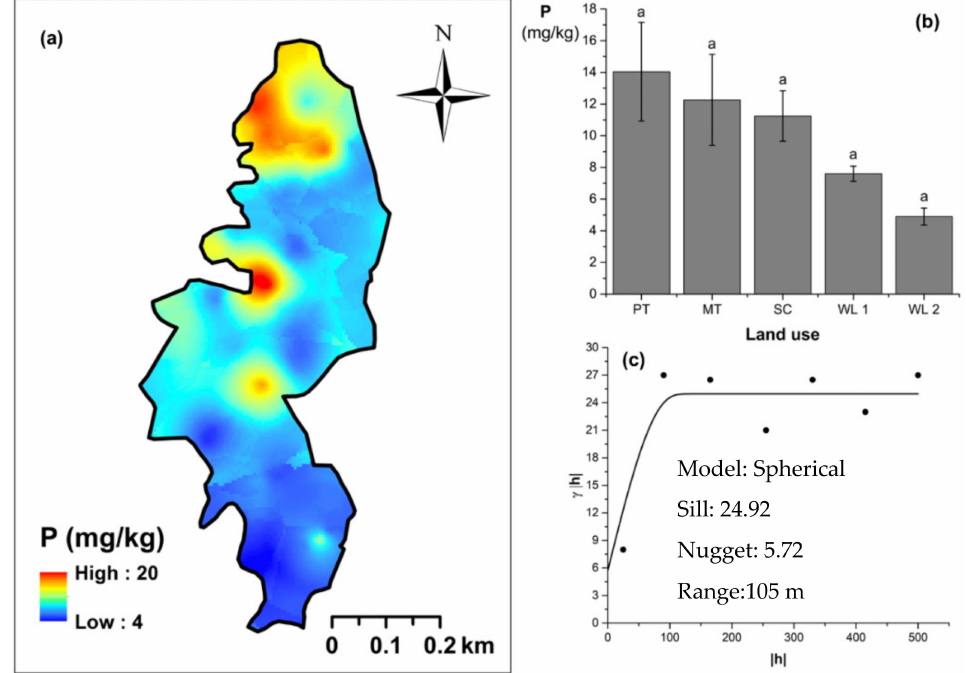
Figure 5. Spatial variability of available phosphorous: ( a ) map, ( b ) bar graph among different land uses (see Figure 1, label A for notations) in the Endane Biodiversity Corridor, and ( c ) variogram between lag distance and semivariance. Semivariance function: γ ( h ) = 5.72 + 0.356 h − 1.076 h 3 . Comparisons depicted by the different letters in the bars in subfigure ( b ) indicate significant pair-wise